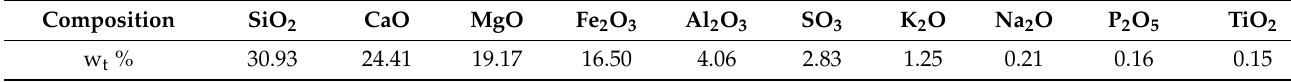
Table 1. Chemical composition and content of anorthite.